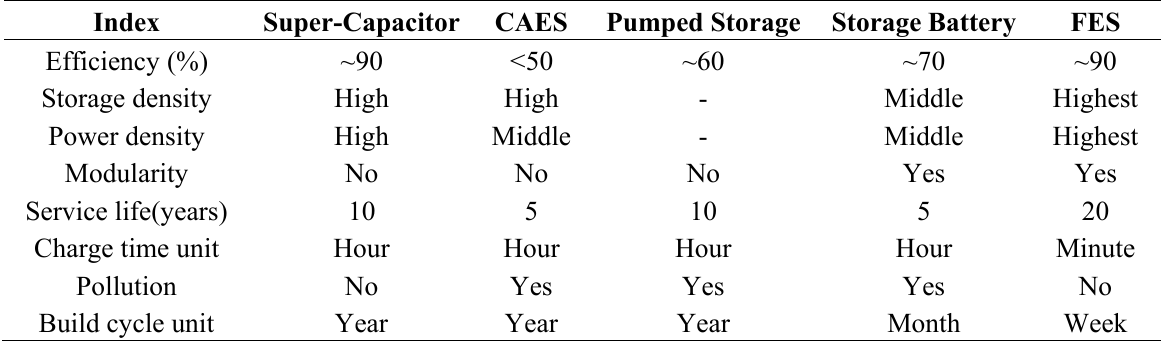
Table 1. Comparison of five storage